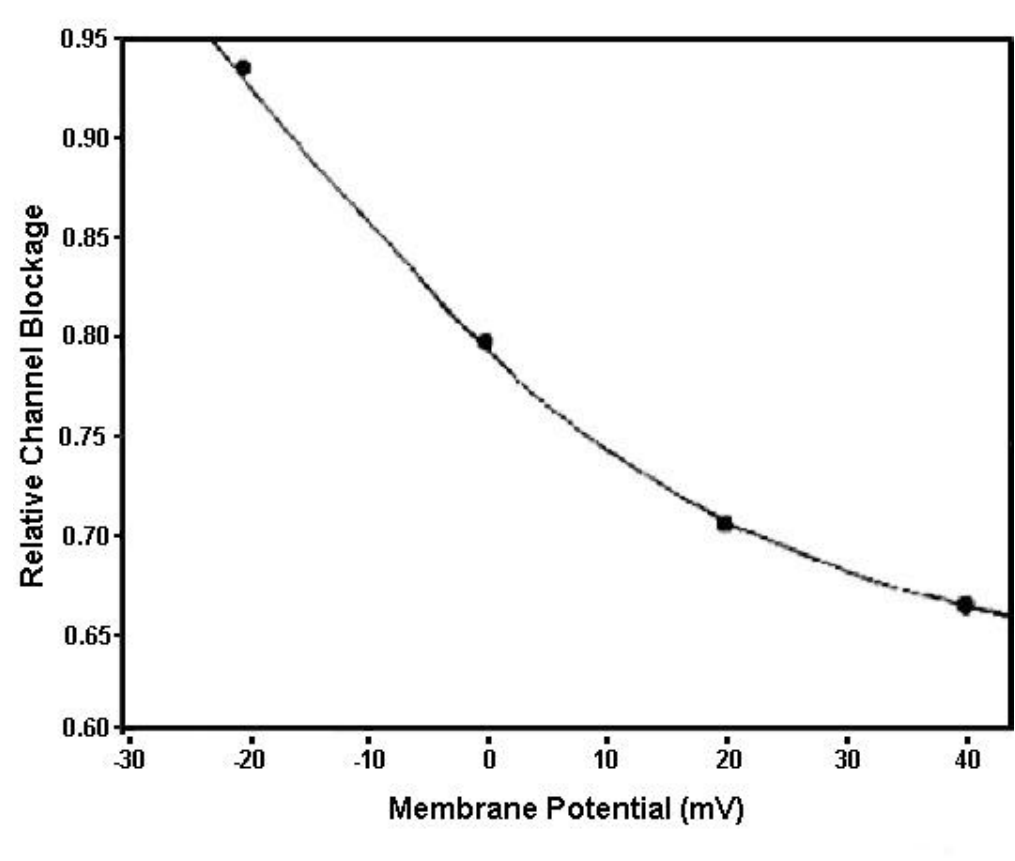
Figure 6d: Voltage-dependence of the channel blocking by P. gravimanus